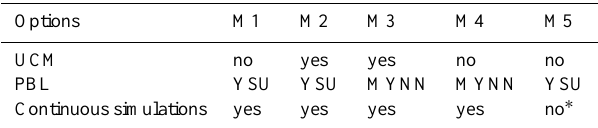
Table 1. Numerical options and physical parameterizations consid-